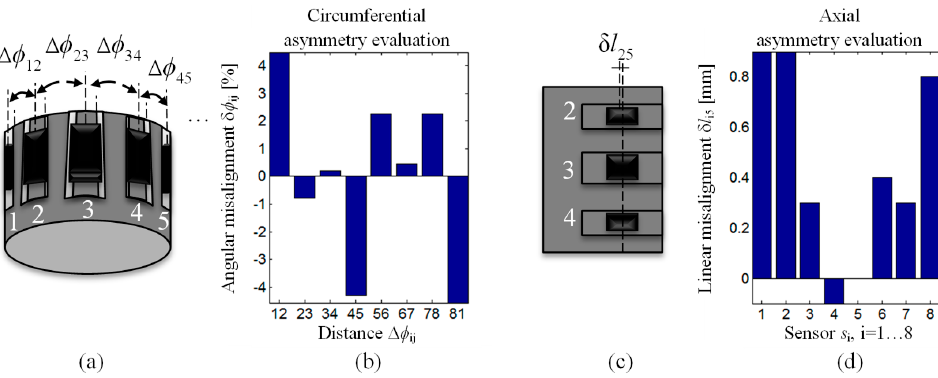
Figure 7. Spatial alignment evaluation of the transducer’s sensors: ( a ) view of the sensor array with depicted angular distances Δ ϕ between two successive sensors,; ( b ) results of the angular misalignment δ ϕ estimation; ( c ) visualization of linear misalignment δ l estimation as a difference between center locations in linear positions of given sensor s i , i = 1, 2, 3, 4, 6, 7, 8, and the sensor s 5 , and ( d ) results of the sensor linear misalignment δ l estimation.